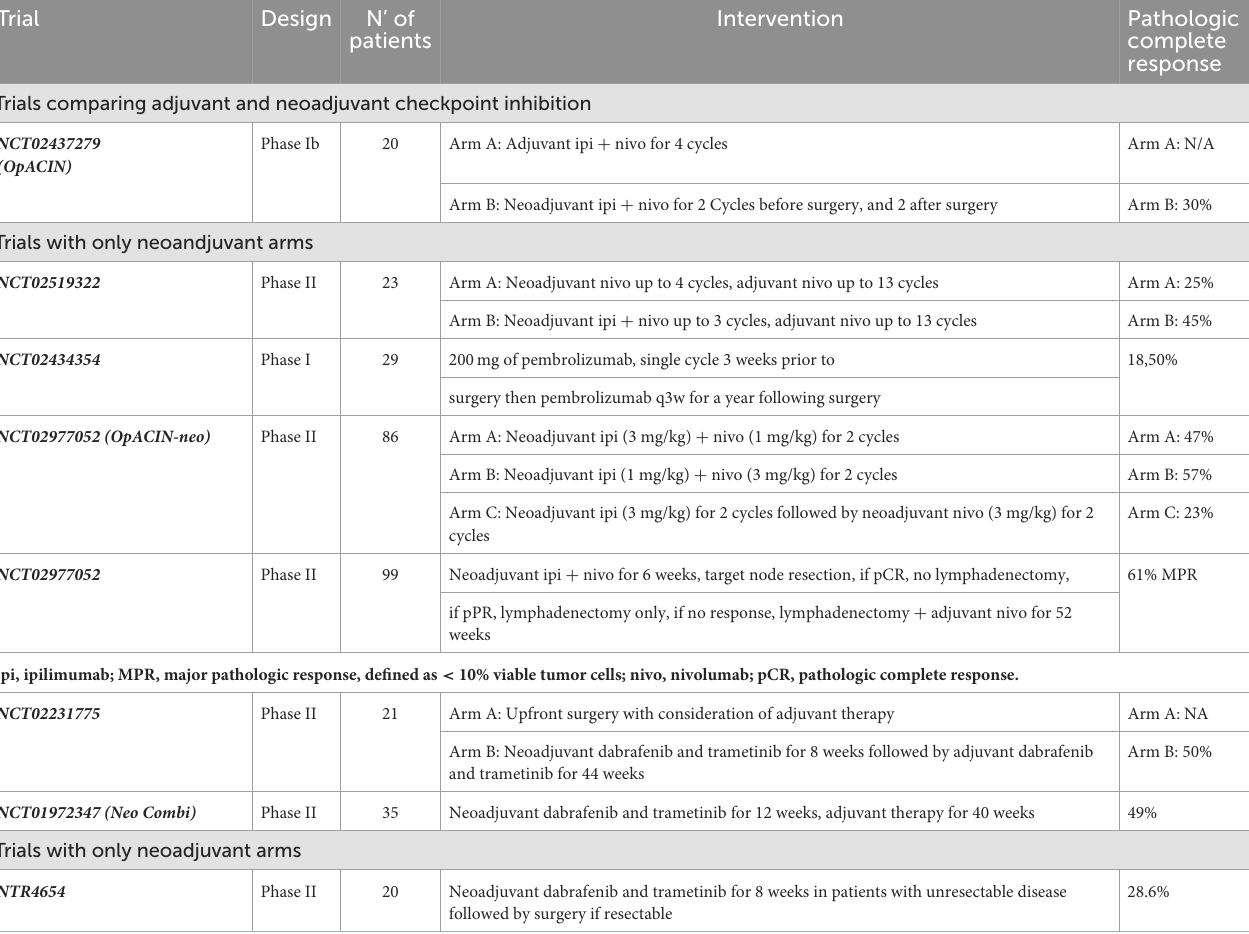
Intervention Pathologic